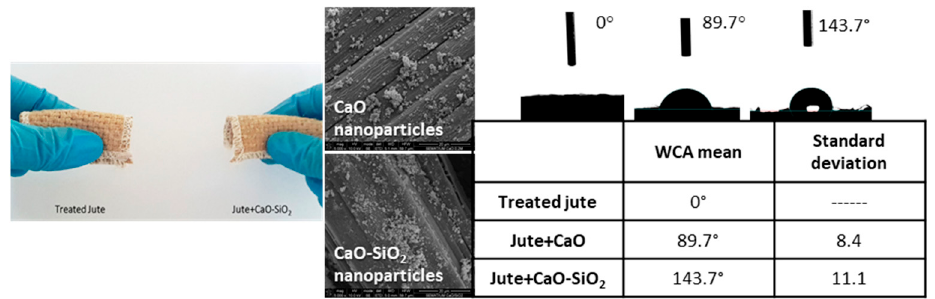
Figure 5. Digital photo and FESEM images of the jute fabrics functionalized with CaO and CaO-SiO 2 NPs and WCA values. Used with permission from [13].